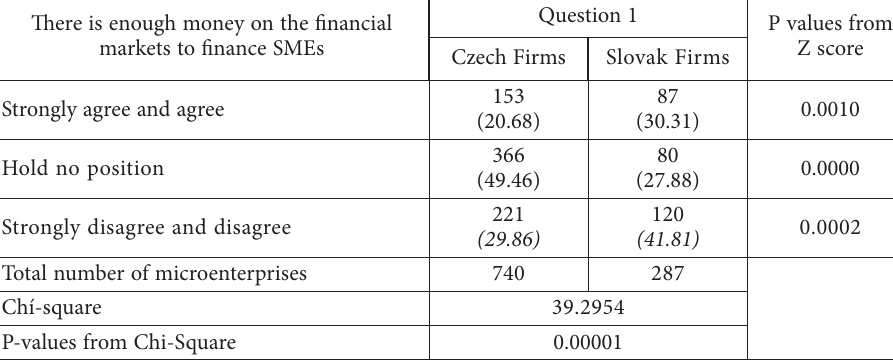
Question 1 P values from Z score Czech Firms Slovak Firms 153